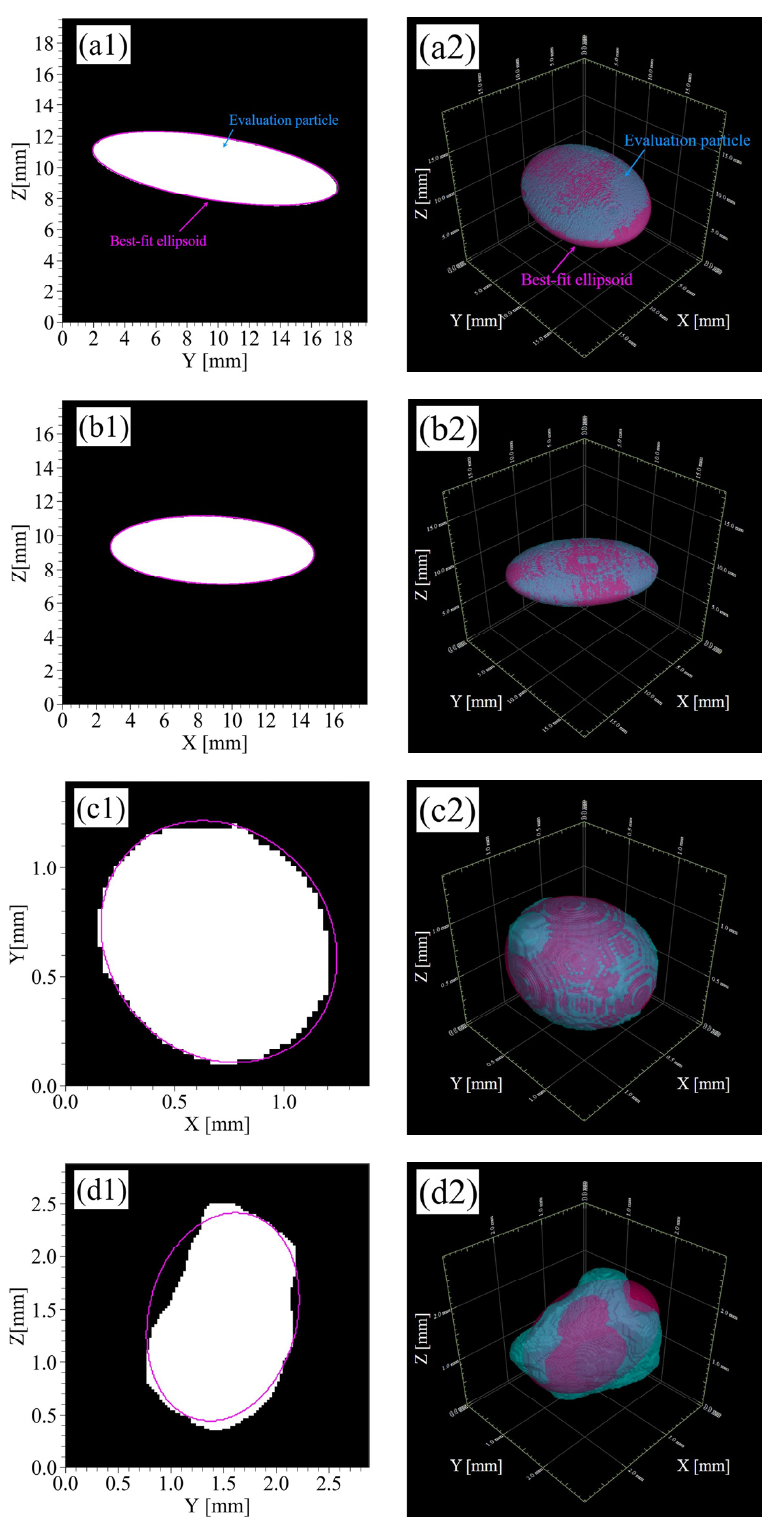
Figure 5. Ellipsoid fitting results: ( a1 , a2 ) RP1 and ( b1 , b2 ) RP2 (resin particles made by a 3D printer), ( c1 , c2 ) GBs (glass beads), and ( d1 , d2 ) KS (Kashima–Keisa natural sand). The left columns are the two-dimensional views, and the right columns are the three-dimensional